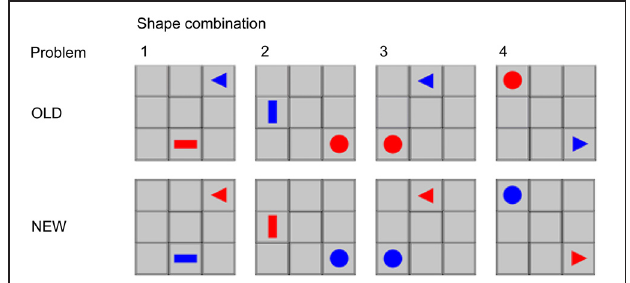
FIGURE 3 | Examples of goal configurations from different communicative problems and the corresponding shape combinations. The tokens are matched in shape for OLD and NEW problems, but with different communicative roles. Note that in shape combination three, the triangle is pointing toward the game board, whereas in shape combination four the triangle is pointing away from the game